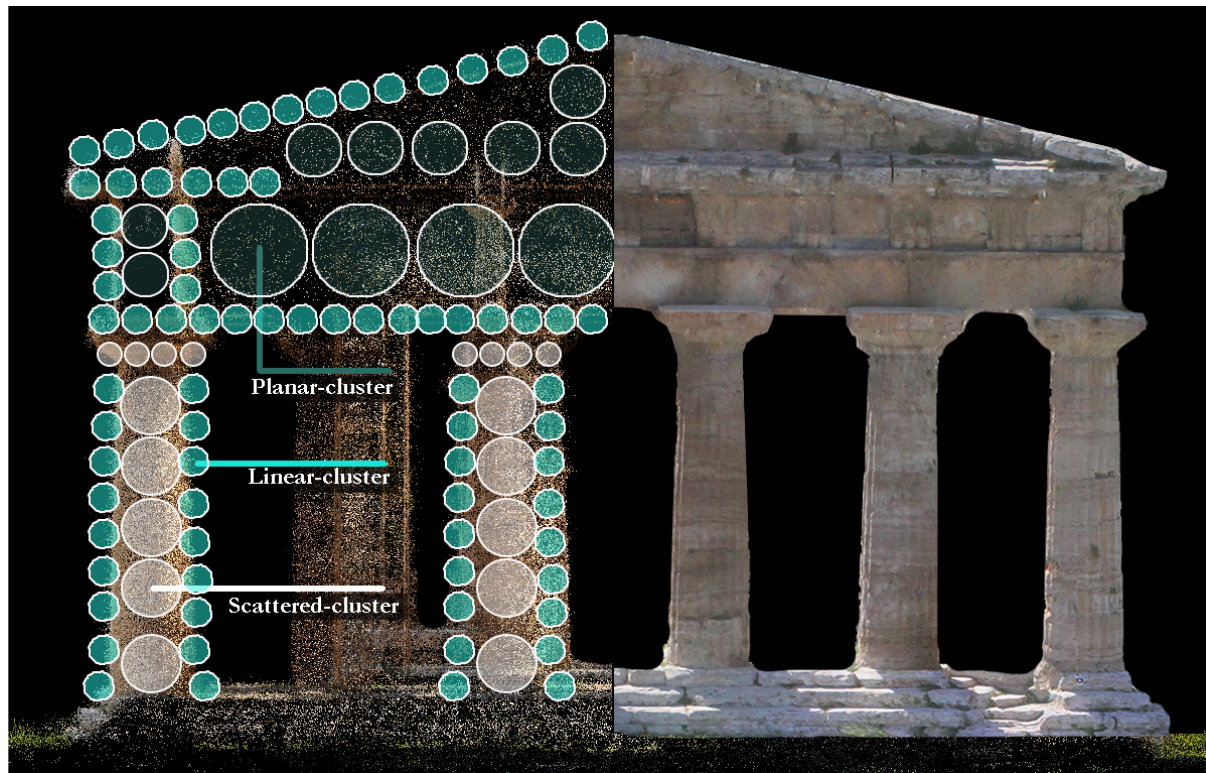
Figure 3: A schematic representation of the adaptive clusters identification, based on the minimization of the entropy defined over the dimensionality classes (Linear – 1D, Planar – 2D, Scatter